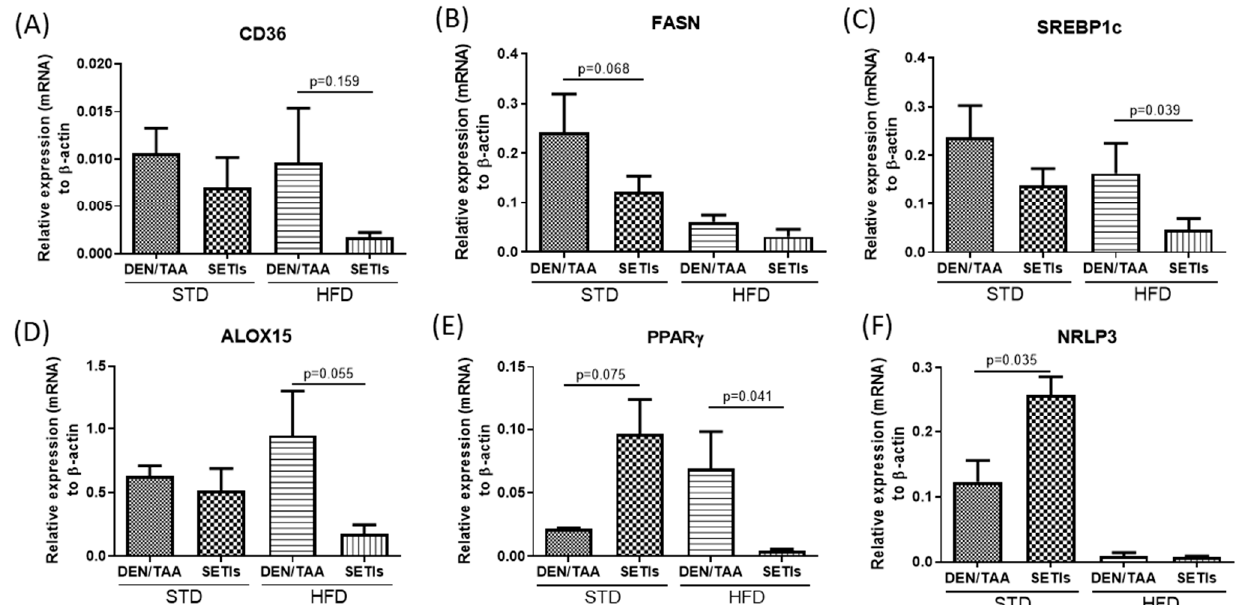
Figure 2. Interaction of SETIs with diet-induced lipid accumulation. Transcript levels (mRNA) of lipogenic markers: ( A ) CD36, fatty acid translocase; ( B ) FASN, fatty acid synthase; ( C ) SREBP1c sterol regulatory element-binding protein 1; ( D ) the coronary risk marker-arachidonate 15-lipoxygenase (ALOX15). Expression levels of the ‘double-edged’ neoplastic markers: ( E ) PPAR γ , Peroxisome proliferator-activated receptor; ( F ) NRLP3 inflammasome. Results are expressed as mean ± mean standard error (SEM) ( n = 4 for panels ( A , F ); n = 6 for panels ( B – D )). Untreated controls are represented by the dotted line.